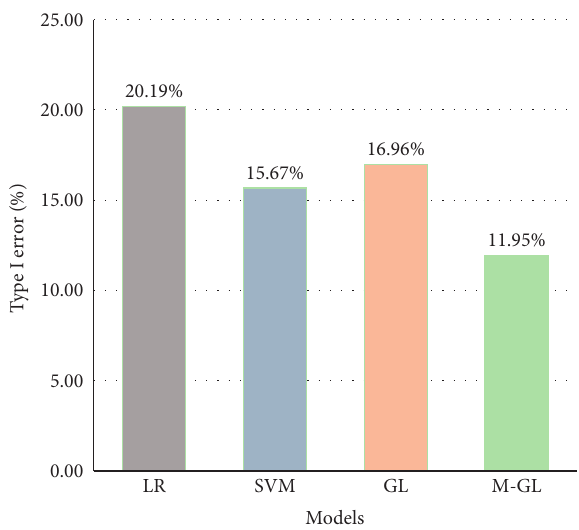
Figure 2: Type I error for different methods.